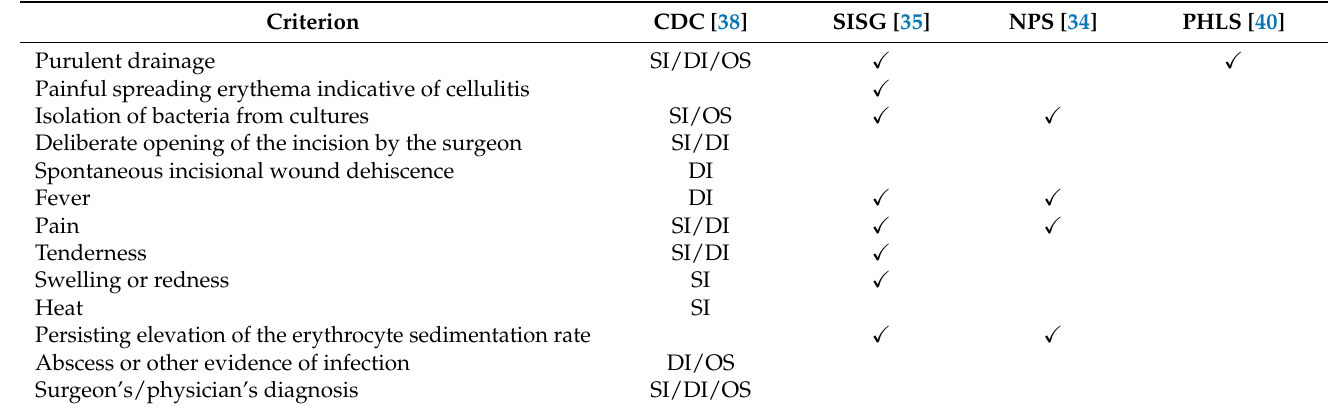
Table 1. Standard definitions of SSI.